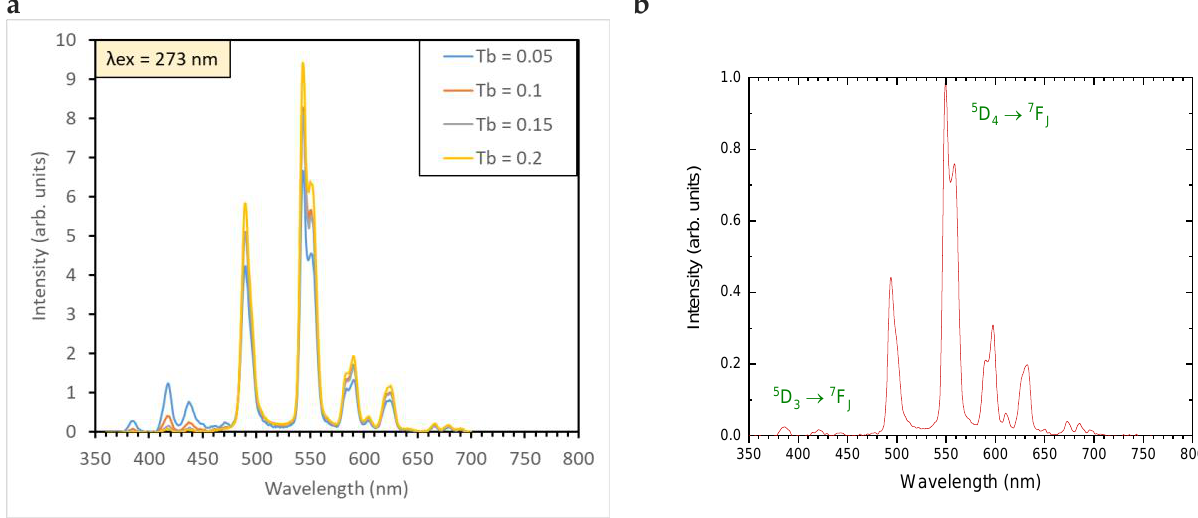
Figure 2. Room temperature PL spectra at excitation in Tb 3+ interconfiguration transition (λex = 273 nm) of GYAGG:Tb samples versus the activator concentration ( a ); scintillation spectrum of the GYAGG:Tb, Tb = 0.15 at excitation by the electron beam at the maximum intensity ( b ). The decay kinetics of PL in the region of the 5 D 4 → 7 F J transition are shown in Figure 3. The kinetics of luminescence from the lower radiative state 5 D 4 practically do not change,